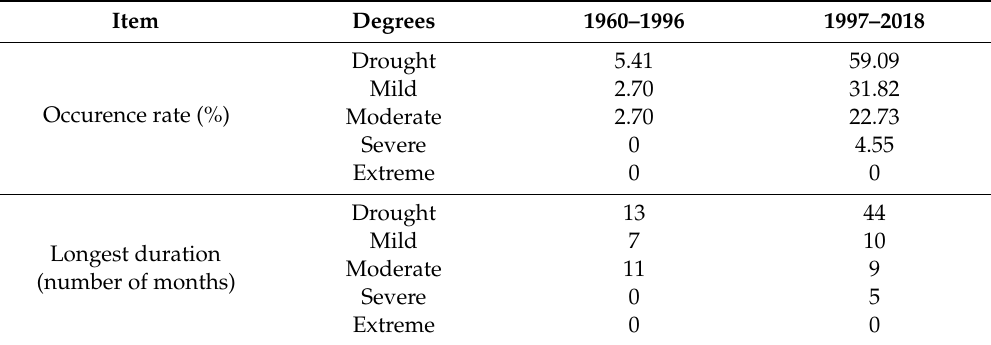
Table 2. Comparison between the occurrence frequency of drought and longest drought duration for the periods of 1960–1996 and